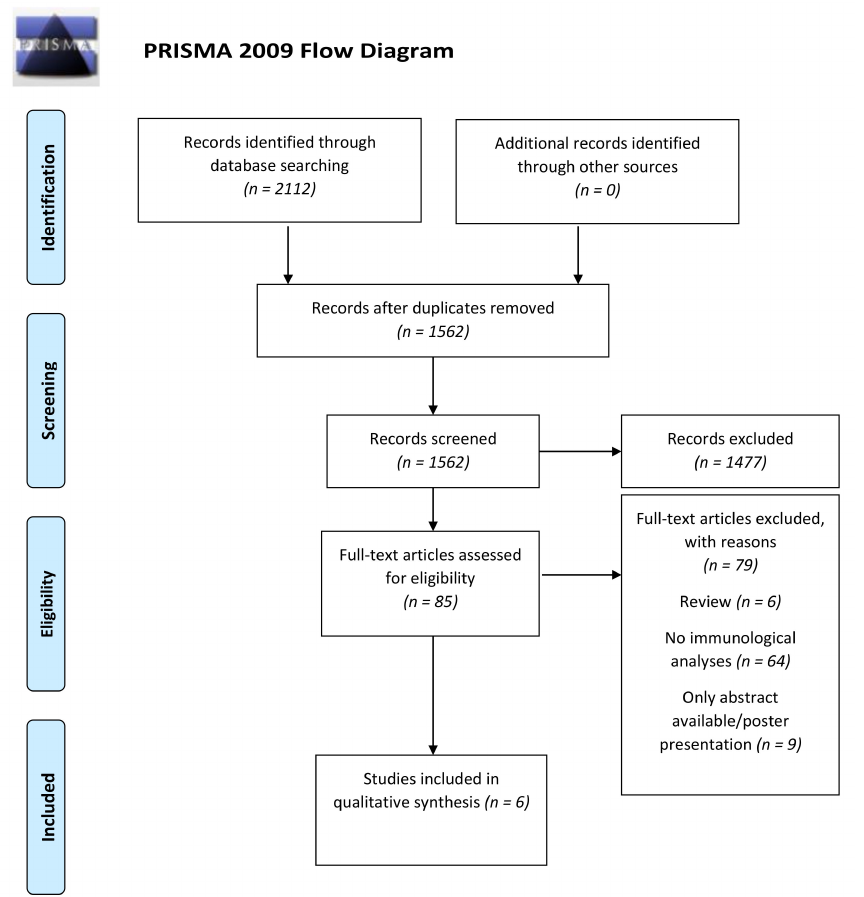
Figure 1. PRISMA Flowchart of the online databases searched and selection of studies for